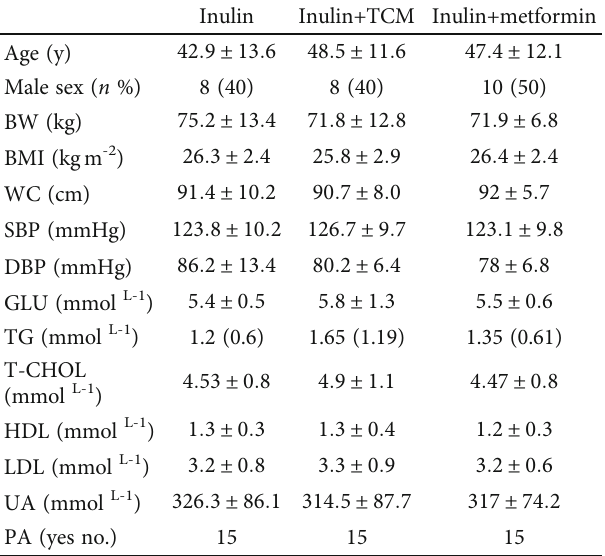
Table 1: Baseline characteristics of participants ( n = 20 per group). Inulin Inulin+TCM